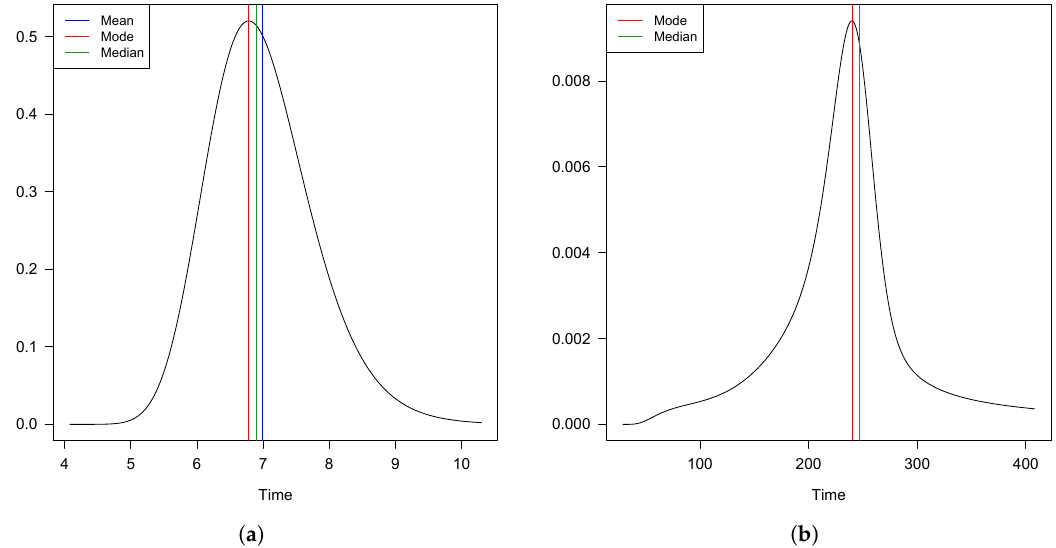
Figure 9. Study of deceased: Probability density functions corresponding to the first-passage times of the estimated multi-sigmoidal Gompertz diffusion process through the constant boundaries S 1 ( a ) and S 2 ( b